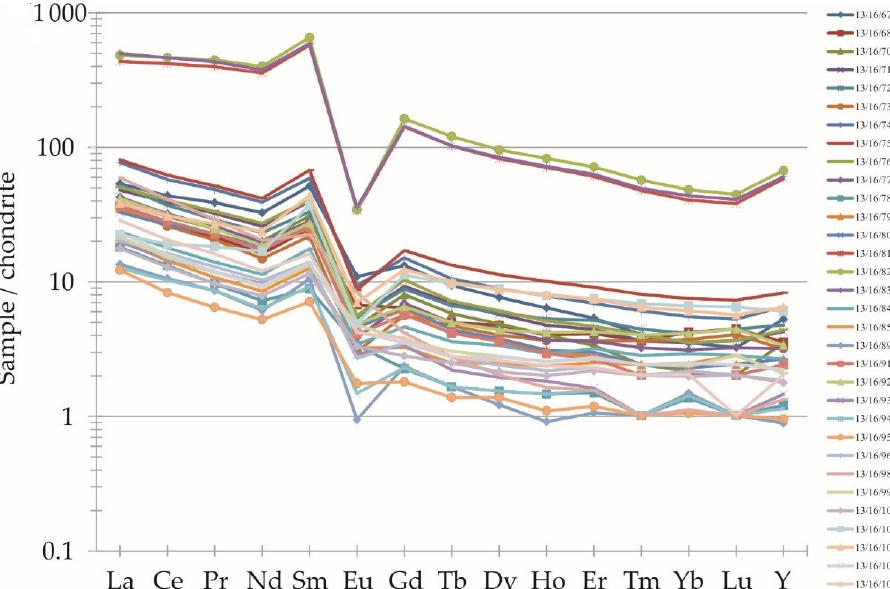
Figure 17. REE diagram normalized to chondrite data after [43] for the Fe-Ti-V ore samples from the Krzemianka and Udryn deposits in NE Poland. Krzemianka and Udryn deposits in NE